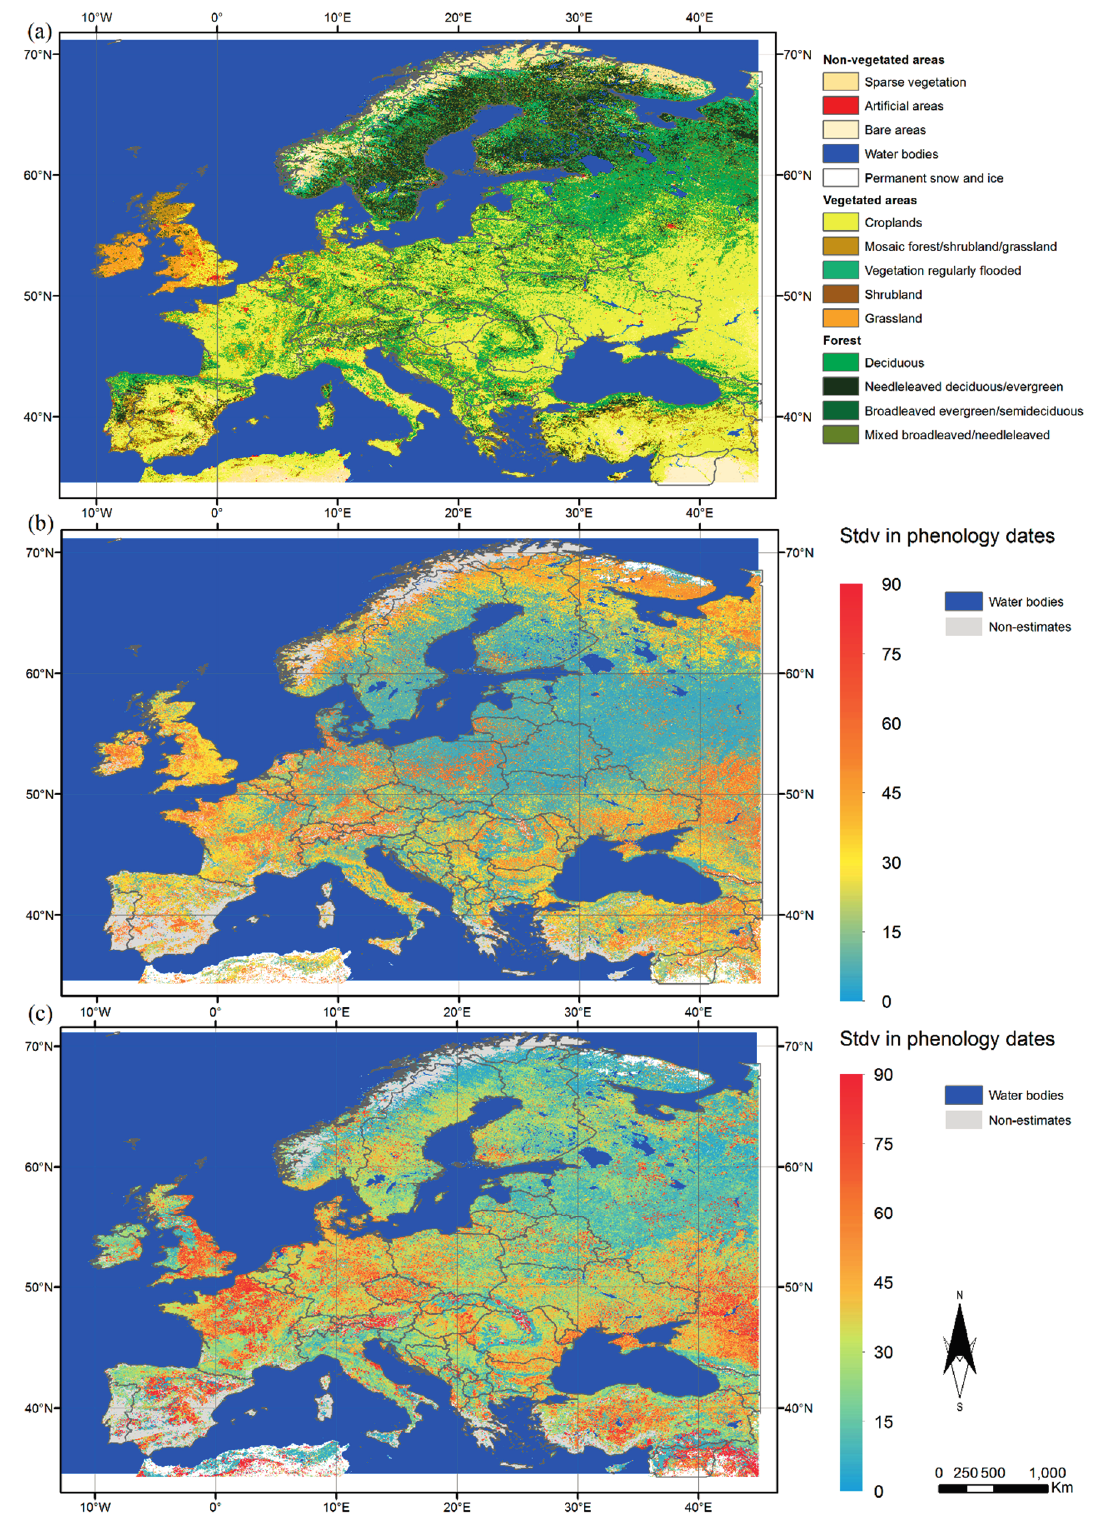
Figure 3. Standard deviation of phenology estimates. ( a ) Spatial distribution of different land cover types (DF); ( b ) onset of greenness (OG); ( c ) end of senescence